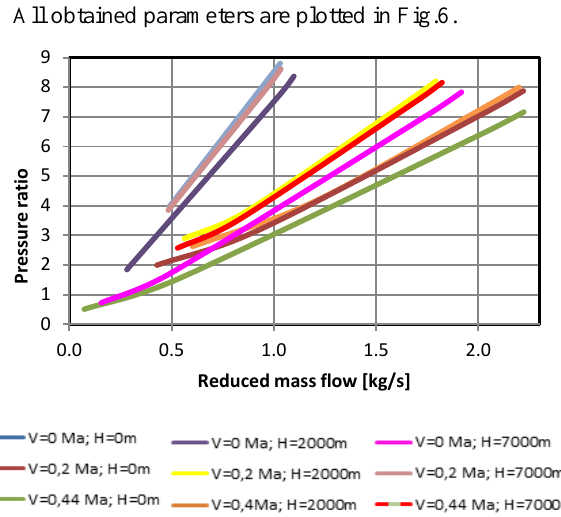
Fig. 6. Compressor map of centrifugal compressor APS 3200 The compressor map of centrifugal compressor of APS 3200 has got characteristic division into three groups like the lines of fan of DGEN 380 and CFM 56-5B. Exactly as in the previous cases it is caused by unstable parameters of flow. Despite the fact this compressor map is plotted based on parameters of compressor in DGEN 380, which is pre- ceded by fan stabilizing the flow, the chart of centrifugal compressor APS 3200 exhibits features of the division into three group, exactly like maps of DGEN 380 fan and CFM 56-5B fan. In fact compressor of APS 3200 is not preceded by any components, which could stabilize the parameters. It means that engine analogy applicable in